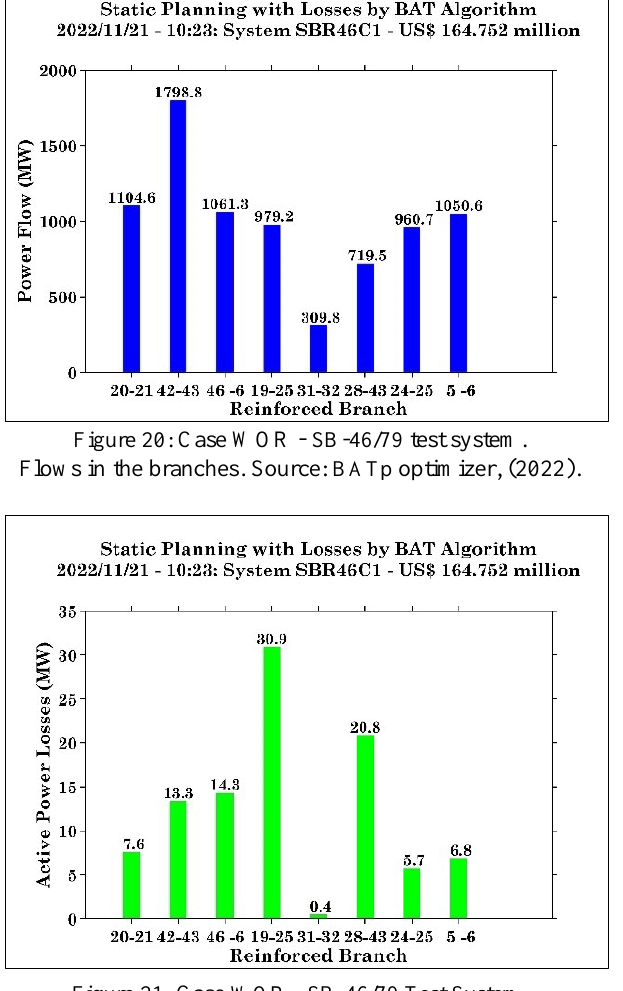
Figure 21: Case WOR - SB-46/79 Test System. Losses in the branches. Source: BATp optimizer,